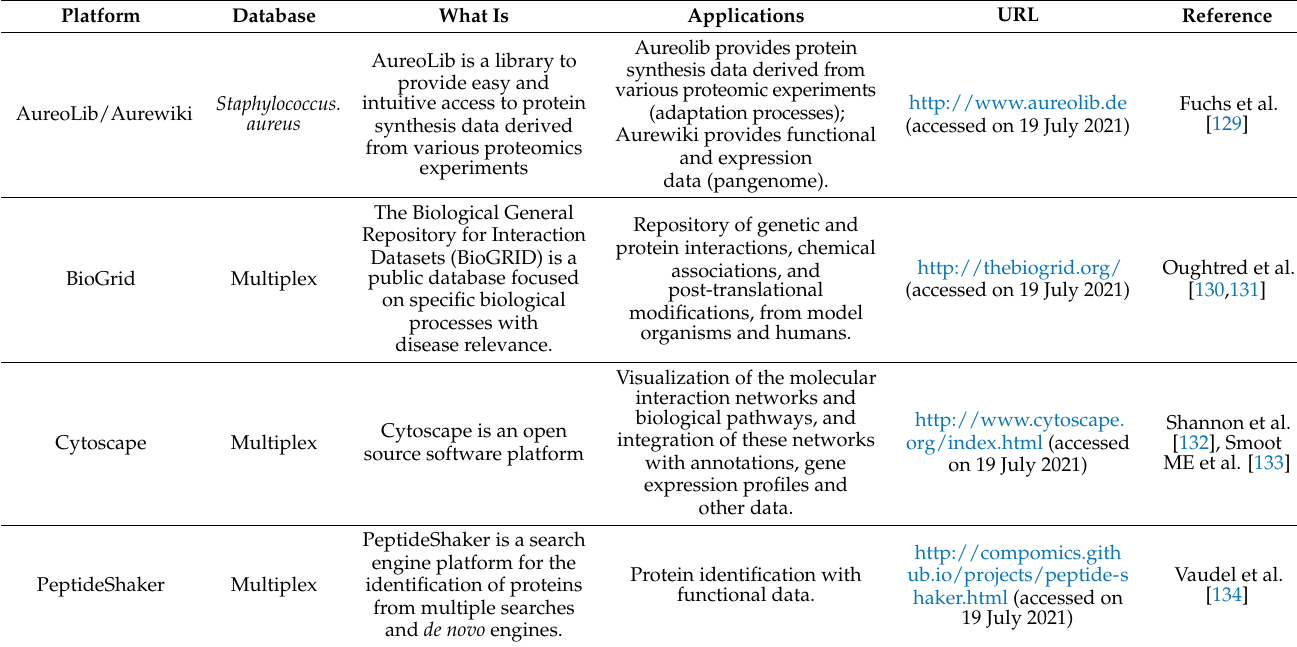
Table 2. Overview of platforms with application for protein